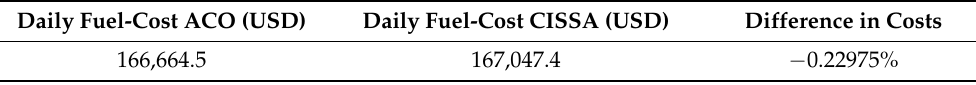
Table 6. Difference in total daily fuel costs—case study